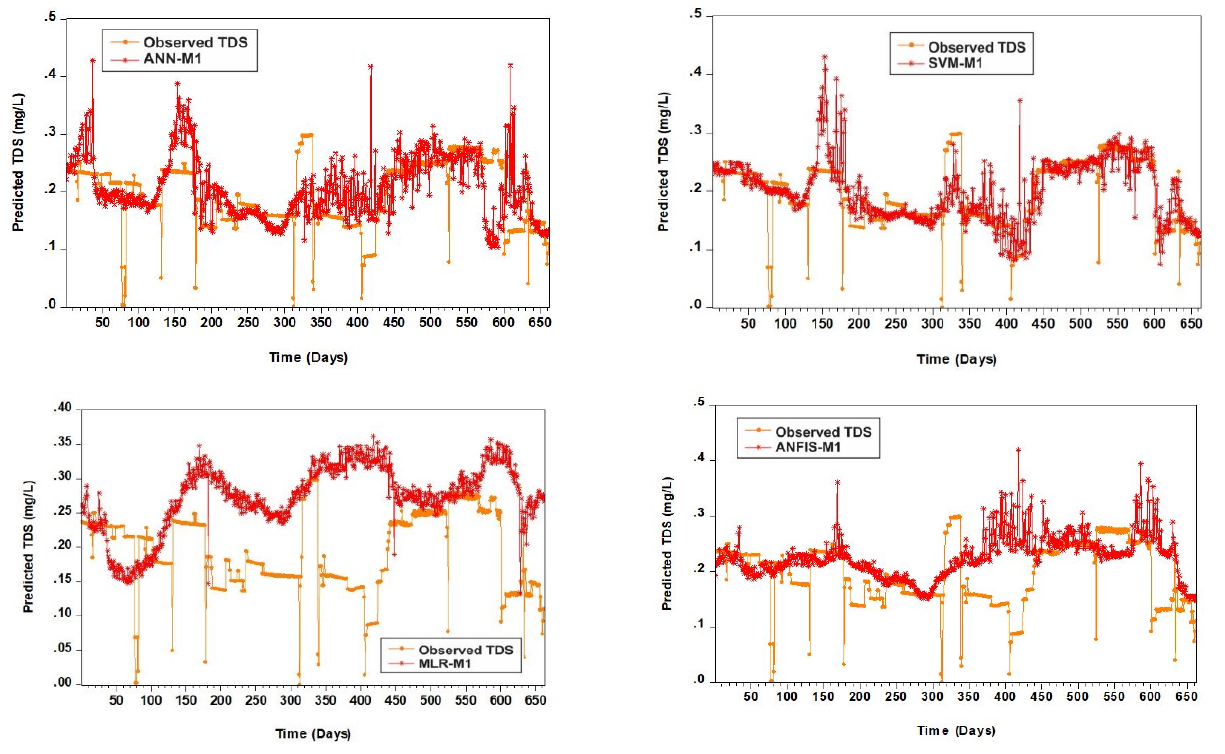
Figure 5. Time-series plot for ANN-M1, ANFIS-M1, SVM-M1, and MLR-M1.